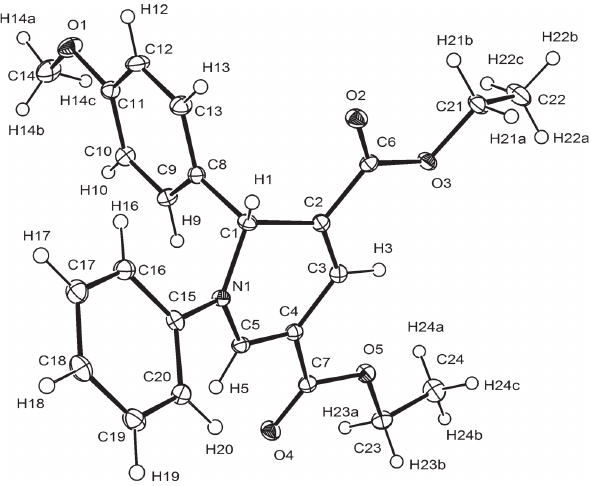
Table 1: Data collection and